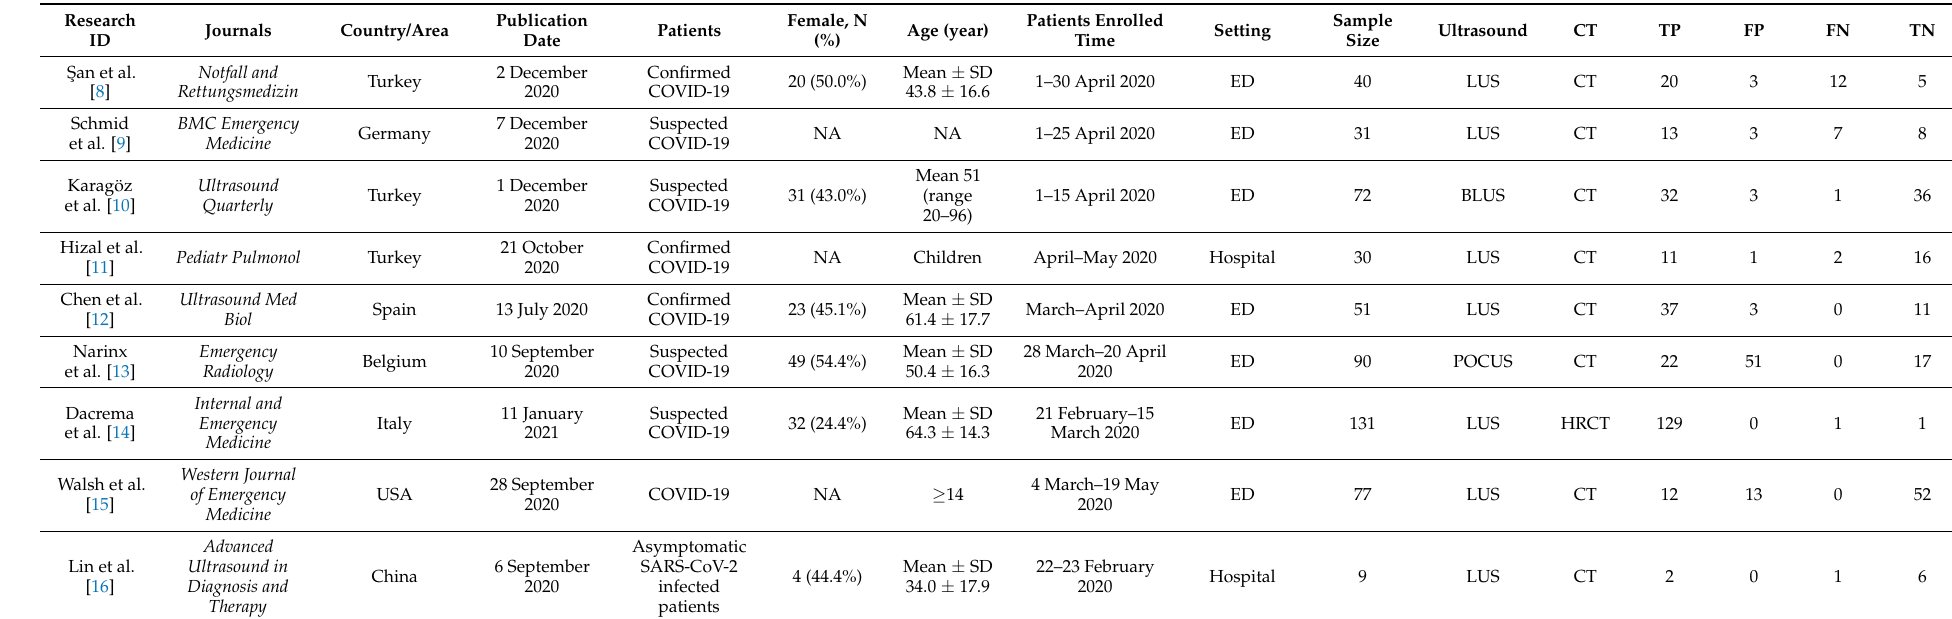
Table 1. Characteristics of the included